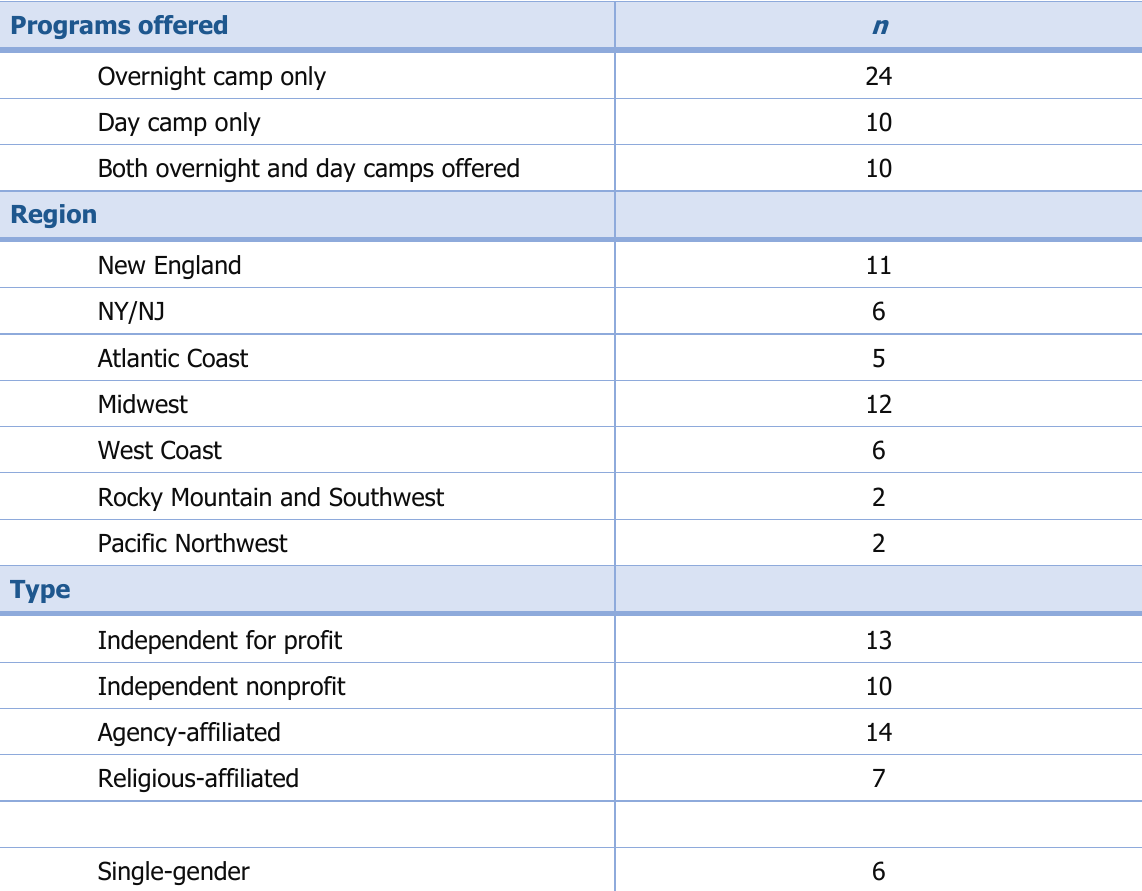
Table 1. Summary of Camps Represented in Study (n = 44) Programs